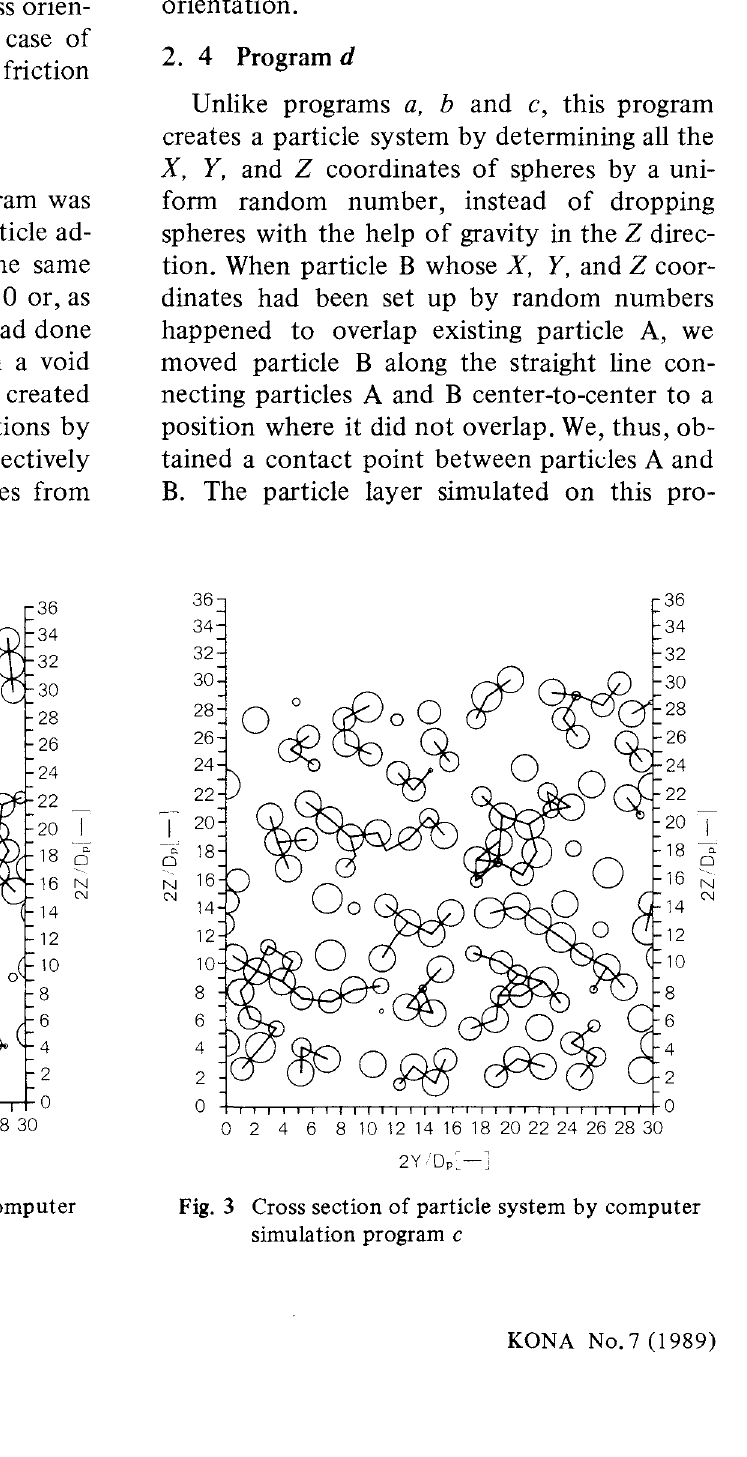
Fig. 3 Cross section of particle system by computer simulation program